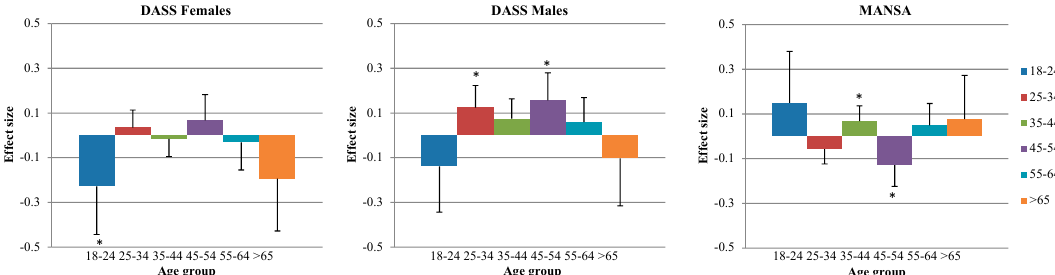
Figure 1. Association between percentage of green space in a 3 km radius and psychological symptoms (DASS) and quality of life (MANSA), by age group and gender. The MANSA graph is not separated by gender as the green space*gender interaction was non-significant in this model. Sample sizes